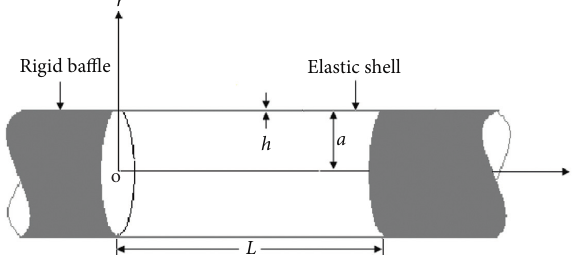
Figure 1: Baffled cylindrical shell and coordinate